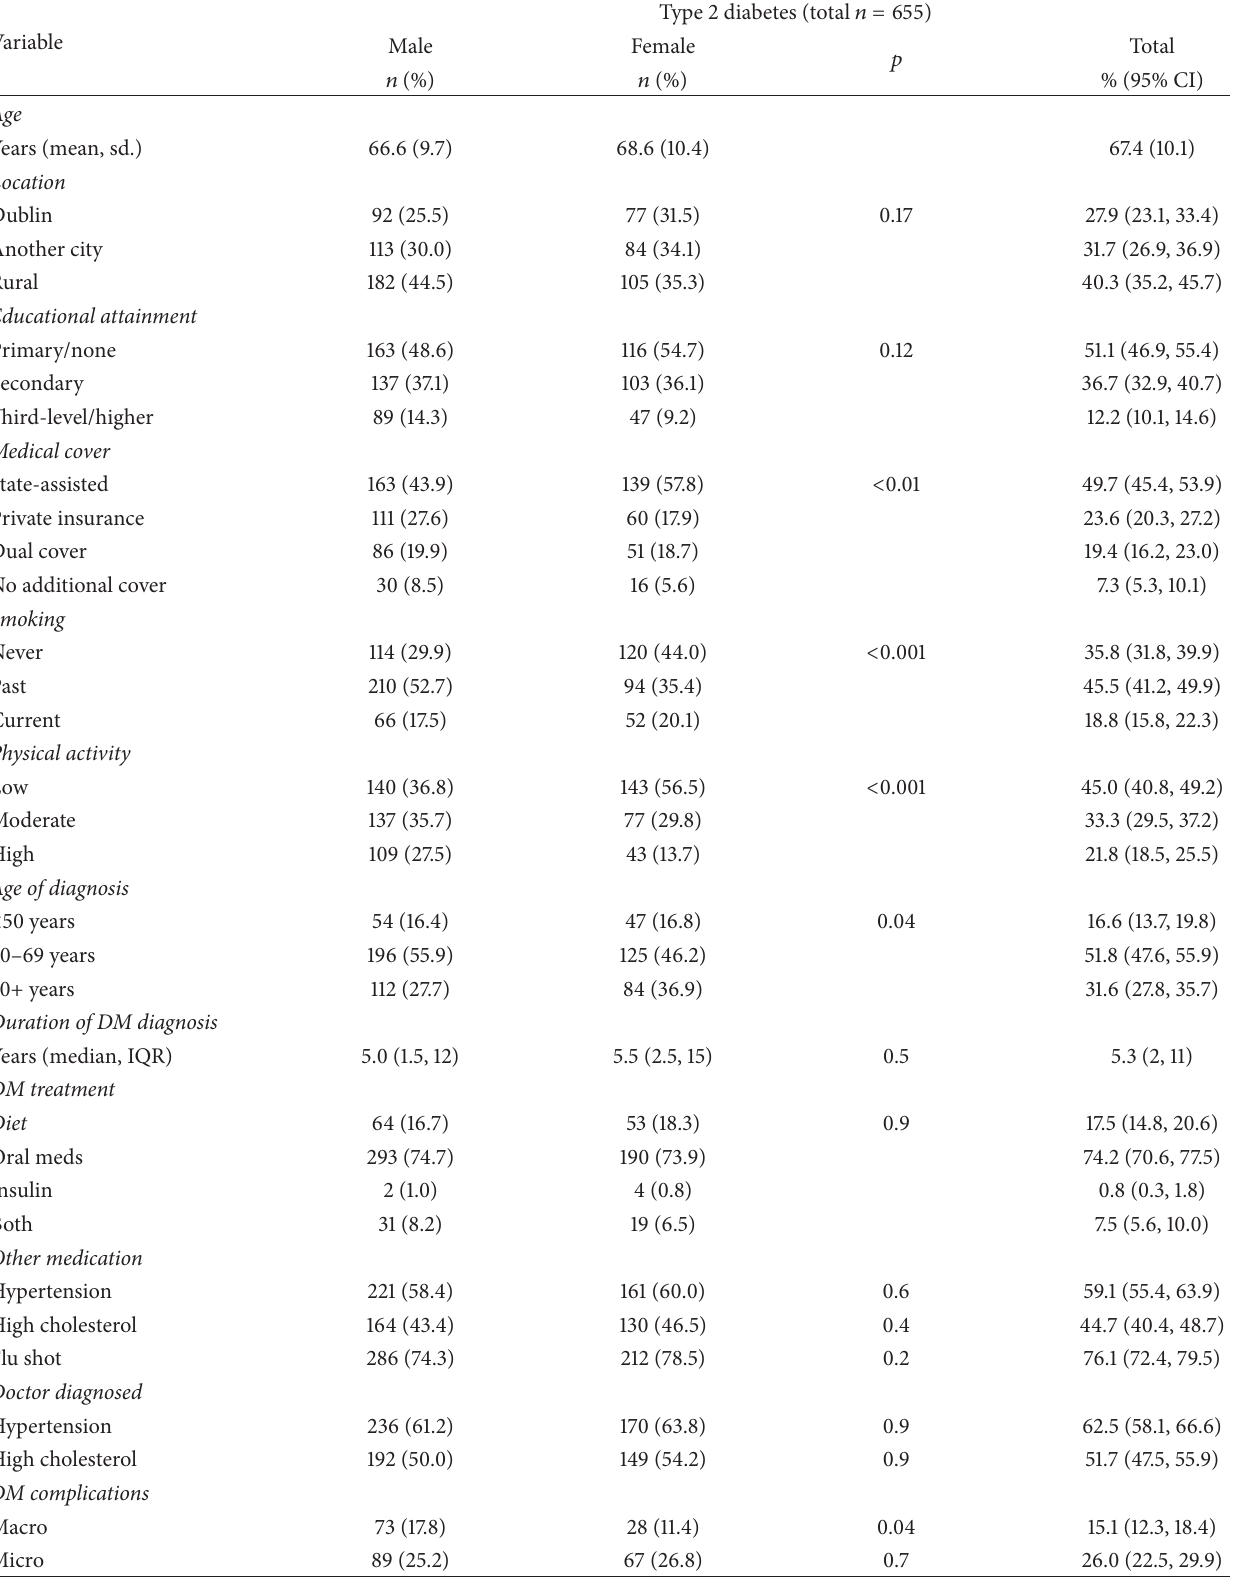
Table 1: Descriptive characteristics of the first-wave TILDA sample aged ≥ 50 years with diagnosed type 2 diabetes,